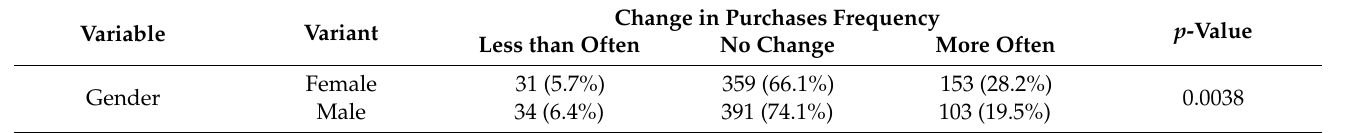
Table 5. Changes in rural e-customers’ gender and changes in purchase frequency during the COVID-19 pandemic (own